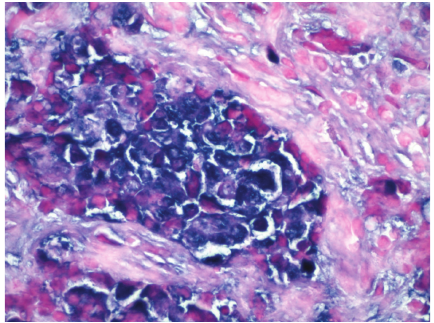
Figure 7: Positive chromogenic in situ hybridization for Epstein- Barr virus encoded early RNAs (slide based EBER CISH study,